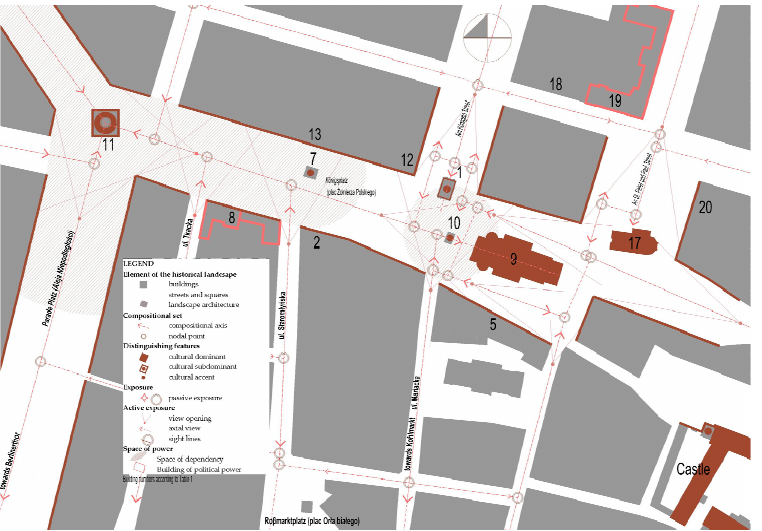
Figure 9. Landscape analysis of plac Ż o ł nierza Polskiego in 1939. The main urban dominant of the square was the City Theatre (9), around which a complex system of urban interiors was composed with a complicated layout of nodal points, compositional axes, axial views and view openings. The space around the theatre was shaped like a trapezoid, with its arms widening to the east. The structure of the square on the northern side was laid out on the levelled modern fortifications in the form of regular perimeter blocks. At the stage of the spatial structure’s development, the view of the Oder in the eastern part of the square was closed off. The nodal point of plac Ż o ł nierza Polskiego and plac Niepodleg ł o ś ci became the canvas for the three-axis street layout. This point was additionally strengthened by the location of a monument symbolic of imperial power (11) (source: created by author).